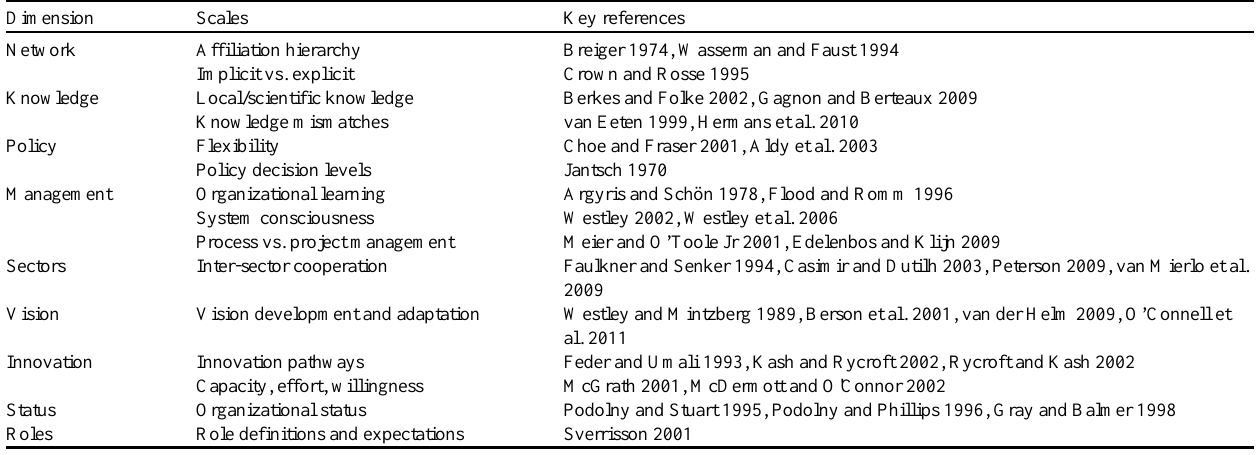
Table 2 . Key references of knowledge domains linked to dimensions and scales from case